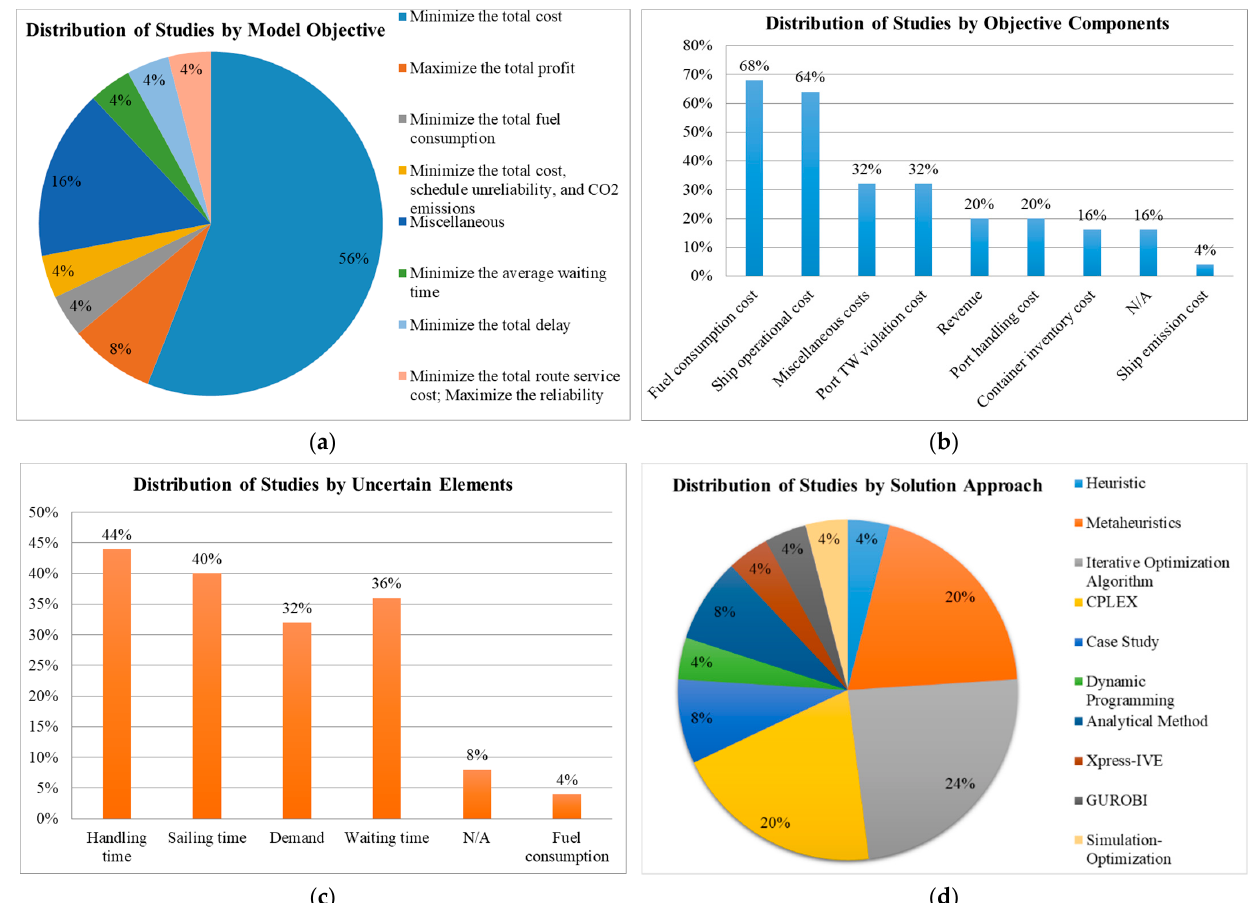
Figure 6. Distribution of the reviewed studies on uncertainties in liner shipping operations by various attributes: ( a ) model objective; ( b ) objective components; ( c ) uncertain elements; and ( d ) solution approach.